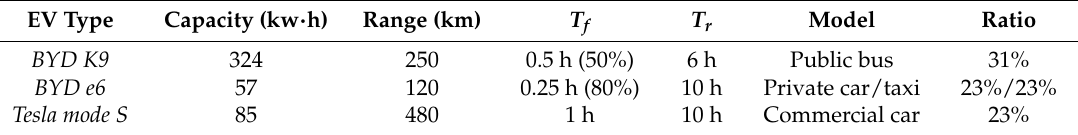
Table 1. Electric vehicle (EV) parameters.